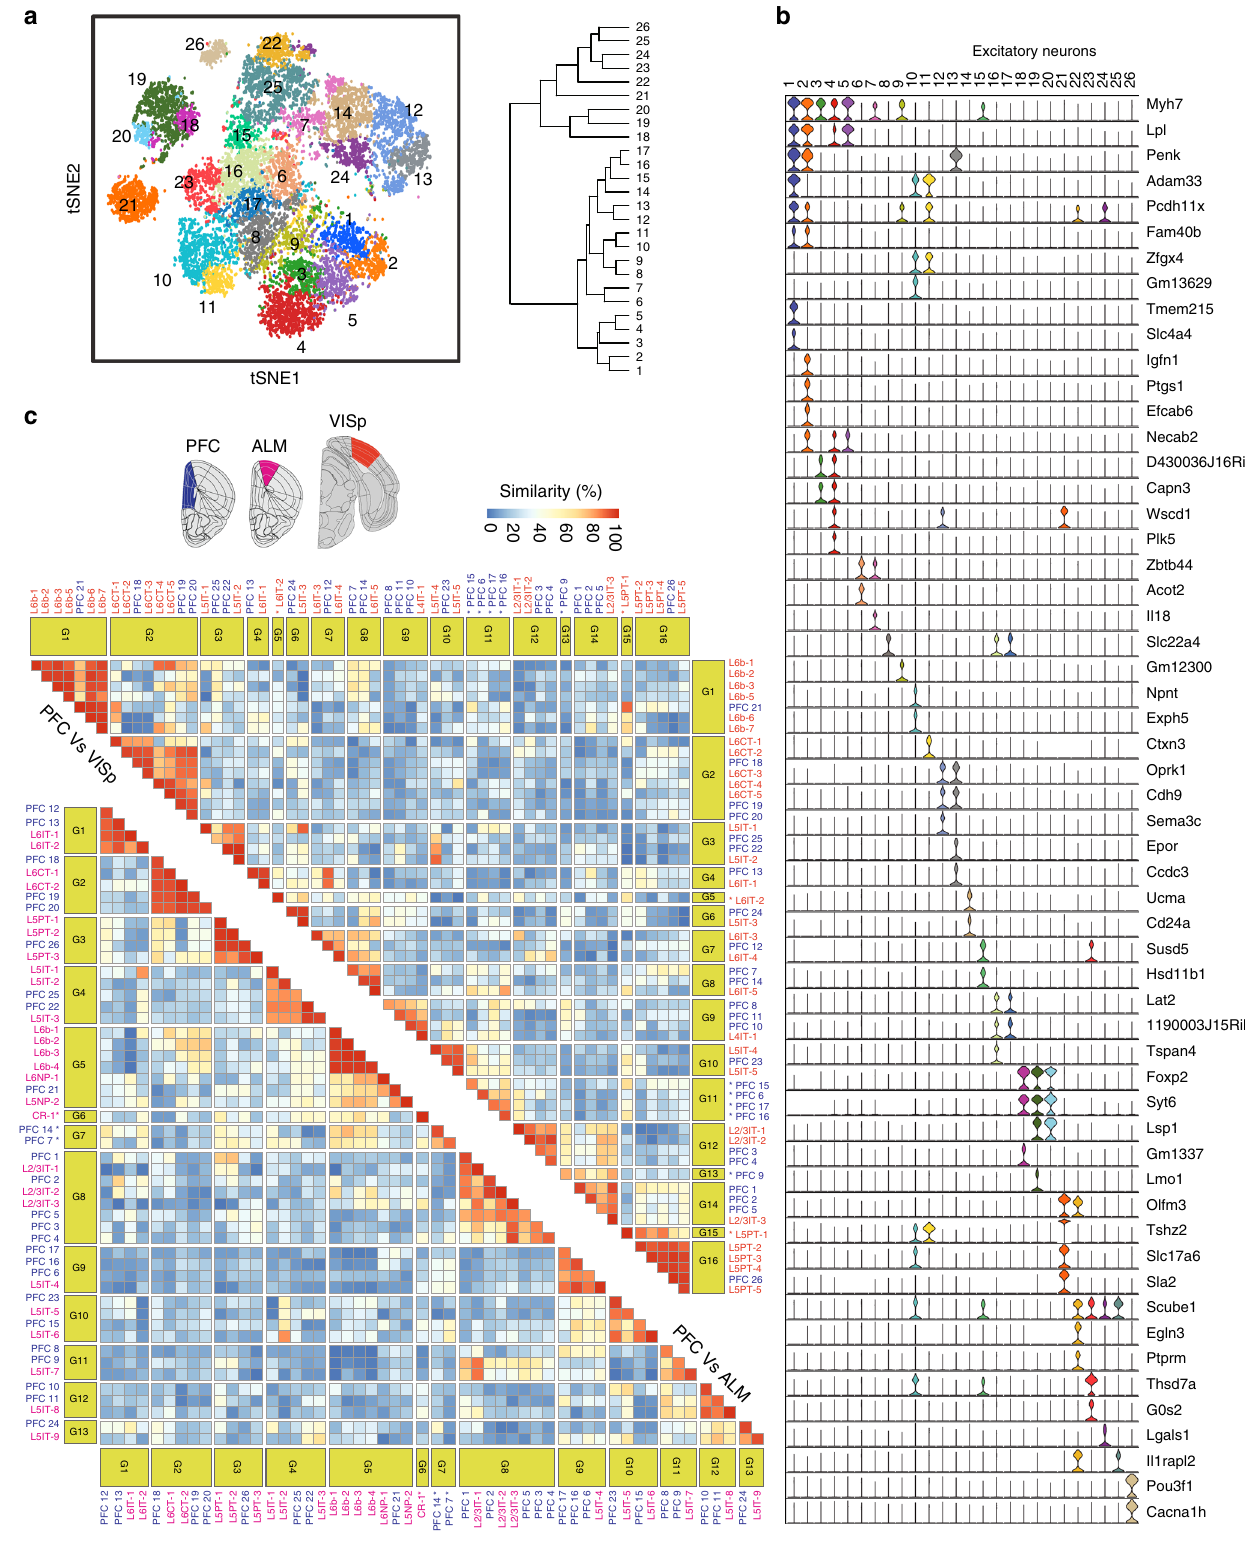
Fig. 3 Distinct transcriptional features of PFC excitatory neurons relative to those of VISp and ALM. a t-SNE plot (left) showing high resolution clustering of PFC excitatory neurons and the dendrogram of hierarchical clustering (right). b Violin plot showing the distinct markers for each of the clusters in a . c Heat map showing the degree of similarity [0 – 100] between the excitatory neuron subtypes in PFC, primary visual cortex (VISp), and anterolateral motor (ALM) based on similarity of transcriptional pro fi les. Subtypes showing a similarity ≥ 90% were clustered together into blocks. Subpopulations showing <90% similarity to any of the subpopulation from the other dataset were considered as region speci fi c (shown with bold font and *). VISp and ALM cluster names were abbreviated, the original corresponding names are available in Supplementary Data